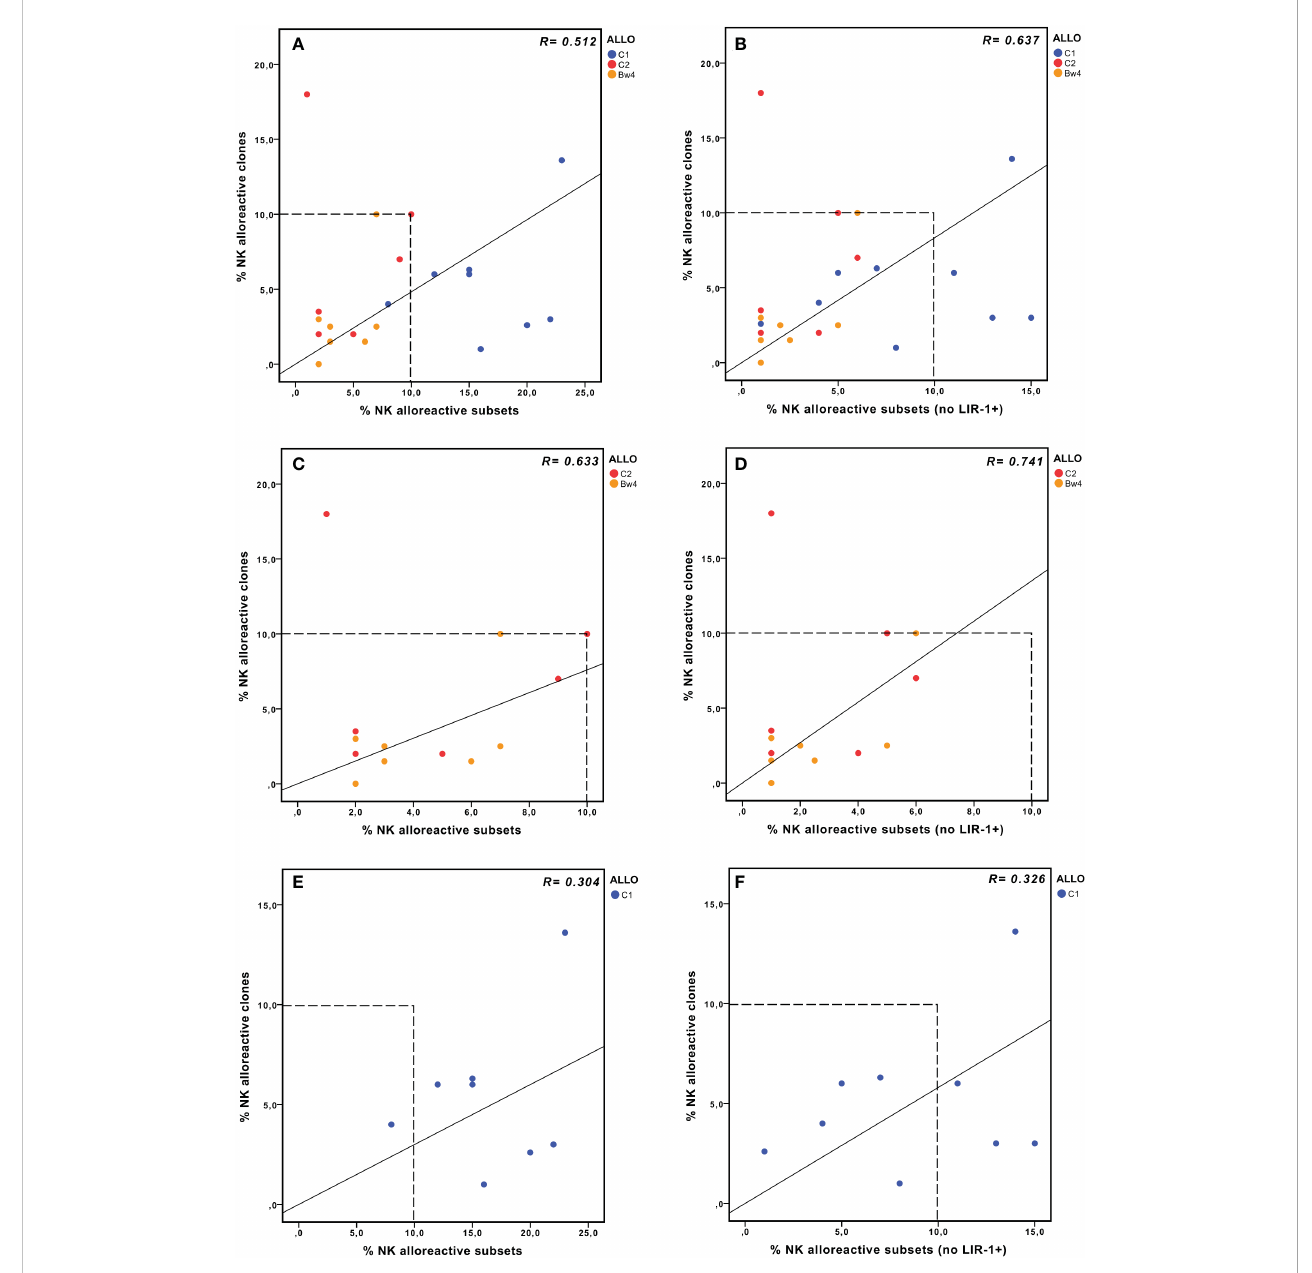
FIGURE 5 NK alloreactivity data from cyto fl uorimetric analysis of PBMC and lytic NK cell clones. Correlation analysis between the values obtained by the two different approaches, considering either the whole cohort (A, B) , Allo Bw4, and Allo C2 only (C, D) , or Allo C1 only (E, F) . The size of the alloreactive NK cell subset phenotypically de fi ned without (A, C, E) or with the further exclusion of LIR1 + cells (B, D, F) . In panels ( A, E ) the % NK alloreactive subset of D of patient #3 (Allo C1, 48% without the exclusion of LIR1 + cells) is not shown because its value is out of the range of the axis, but it was considered in the correlation